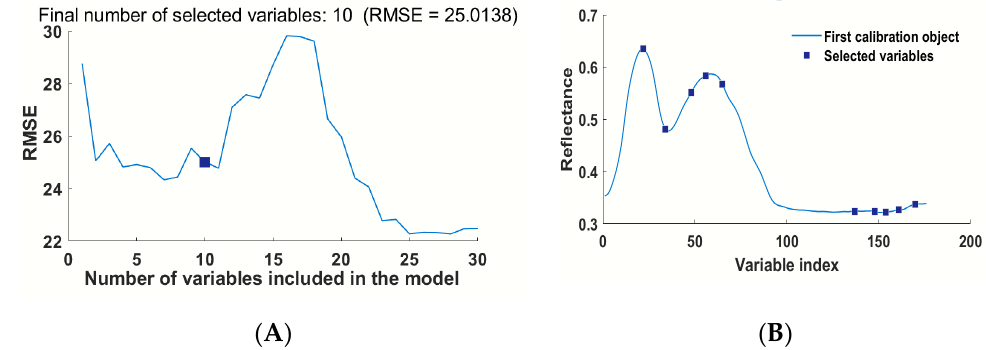
Figure 5. Characteristic wavelength of SPA extraction; RMSE plots obtained by SPA ( A ), the bands selected by SPA algorithm ( B ).